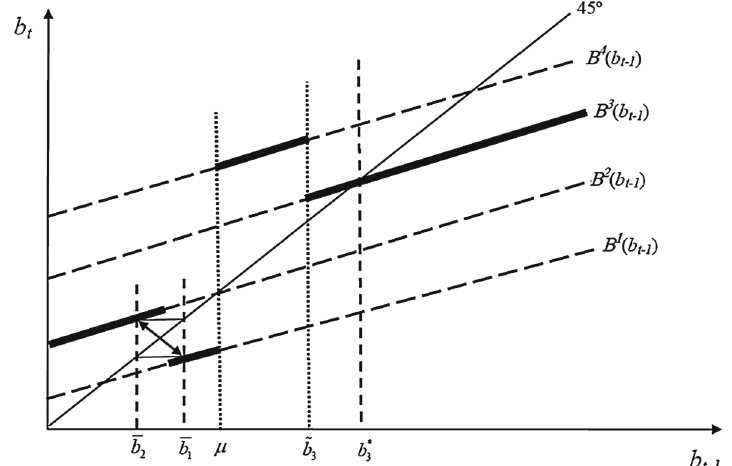
Fig. 8 Equilibria after a large reduction in the cost μ of education. (Source: Alonso-Carrera et al.